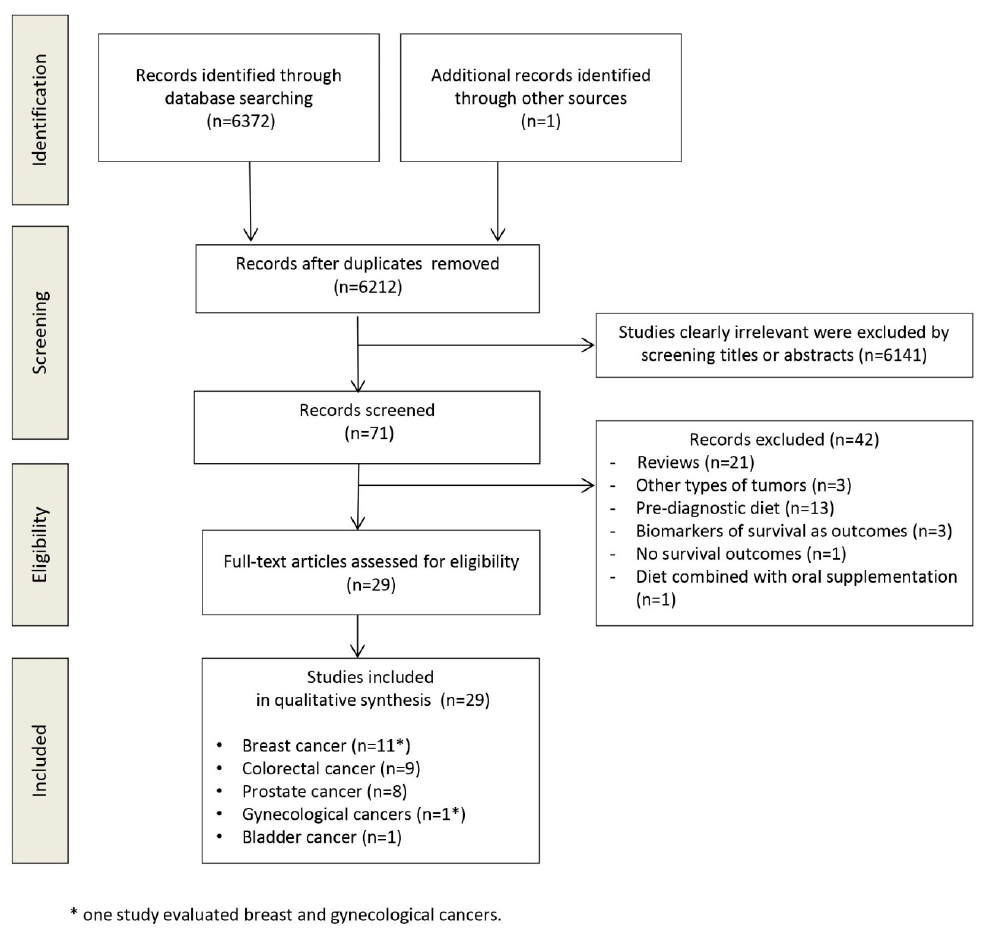
Figure 1. Preferred reporting items for systematic reviews and meta-analyses (PRISMA) flow diagram .